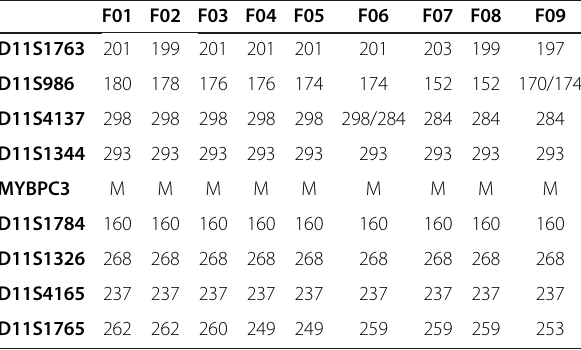
Table 4 Haplotypes associated with the IVS20-2 mutation in the 9 families (F01 to F09)